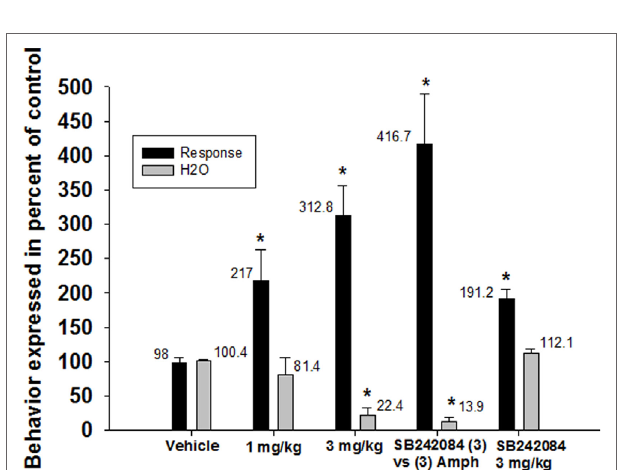
FigUre 4 | effects of 5-hT 2c receptor antagonism on the reductions in schedule-induced polydipsia produced by d -amphetamine . d -Amphetamine significantly enhanced the number of responses emitted ( F 2,19 = 18.4, p < 0.0001) and significantly decreased the amount of water consumed ( F 2,19 = 24.9, p < 0.0001). SB-242084 did not block these effects of d -amphetamine Each bar represents the mean ± SEM of five to eight rats. * p < 0.05 compared to vehicle (Dunnett’s test).